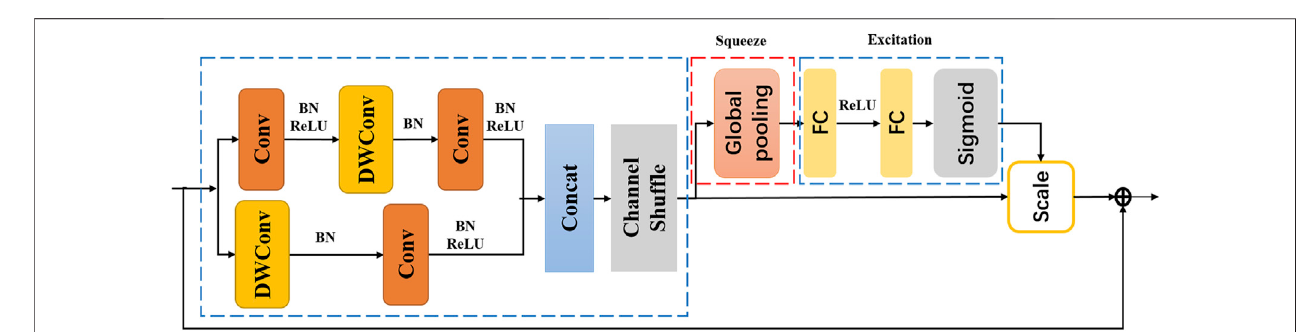
FIGURE 3 | The structure of